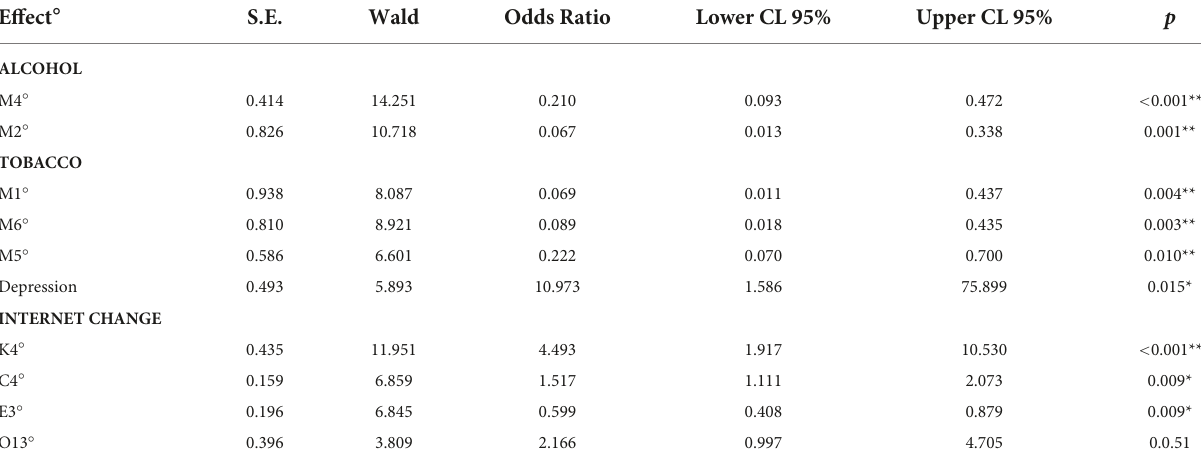
TABLE 4 Factors associated with alcohol, tobacco consumption and change in internet use during